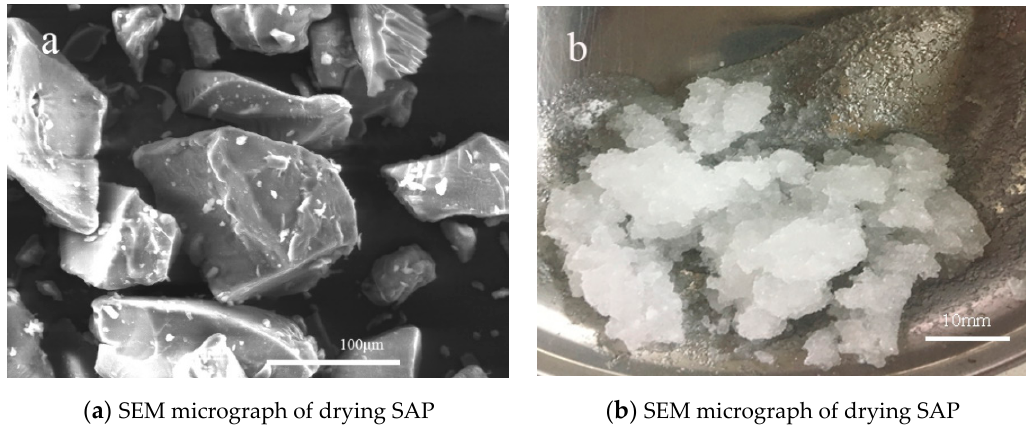
Figure 1. The superabsorbent polymer (SAP) particle characteristics: scanning electron microscopy (SEM) micrograph ( a ) and swelled image ( b ).